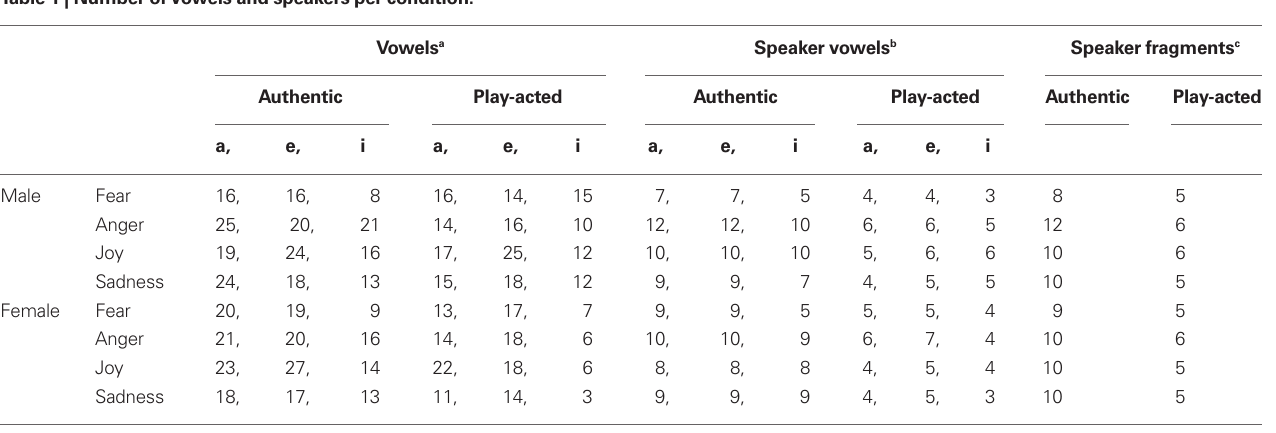
Table 1 | Number of vowels and speakers per